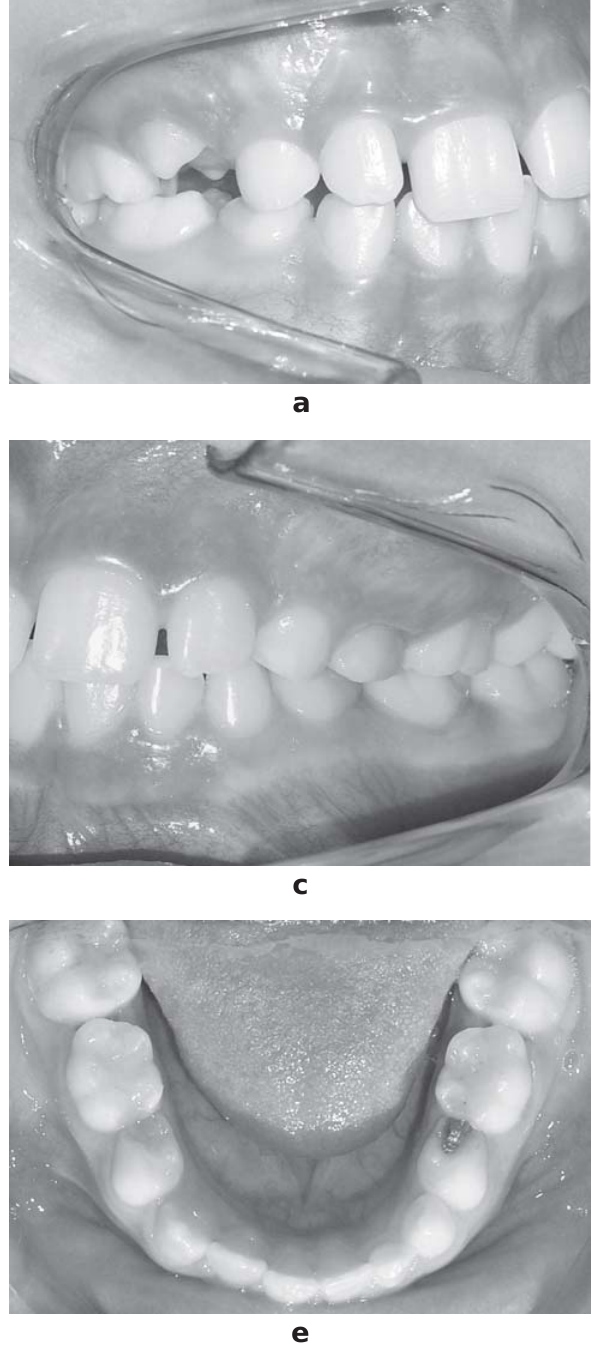
FIGURE 1- (a-f) Initial intraoral photographs and panoramic